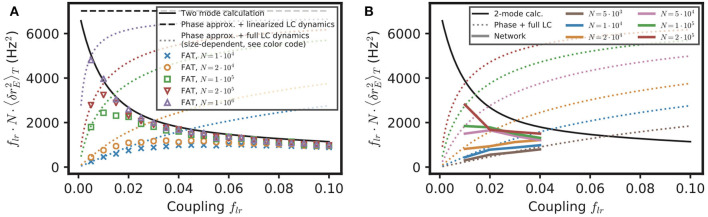
Competition between synchronization and noise for two E–I modules with E → E, I connectivity: theory vs. simulations. The variance of excitatory activity between the two modules 〈δrE2〉=〈(r1,E-r2,E)2〉/2 is shown as a function of coupling strength flr. (A) Simulations of the stochastic rate model (FAT, duration 100 s, averaged over three repetitions) for different noise strengths (color symbols), as specified in the insert in term of the number of neurons N in the individual E–I module. These simulation results are plotted against theoretical predictions with different approximations. For very small coupling strengths, the phase approximation with the full limit cycle dynamics (Equations 16, 82, dotted lines) gives a good account of the observed synchronization, while for larger couplings both phase and amplitude modulations have to be considered (two-mode calculation, Equation 98, solid black line). Note that for very small couplings, the two-mode calculation coincides with the phase approximation with linearized limit cycle dynamics (Equations 16,80, dashed black line), which does not take into account the periodicity of the firing rate as a function of the phase and which predicts an unphysical diverging activity difference for vanishing coupling. (B) Same as in (A) with the results for the network simulations of Figures 4K,L (colored solid lines corresponding to different E–I module sizes, as sprecified in the inset), shown as 〈δrE2〉=C11(0)-C12(0).